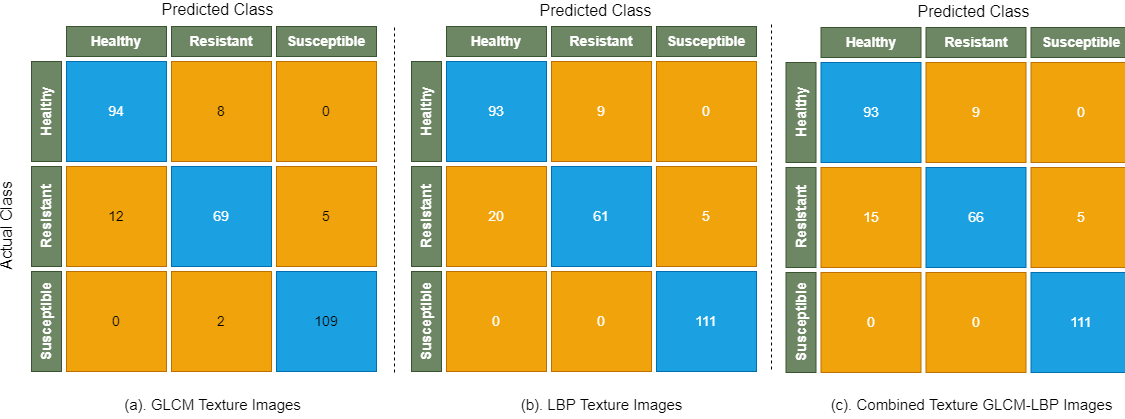
Figure 7. Confusion matrix of Random Forest on GLCM, LBP, and combined texture GLCM-LBP images. Table 4. Performance comparison for LightGBM classification on GLCM, LBP, and combined texture GLCM-LBP images.